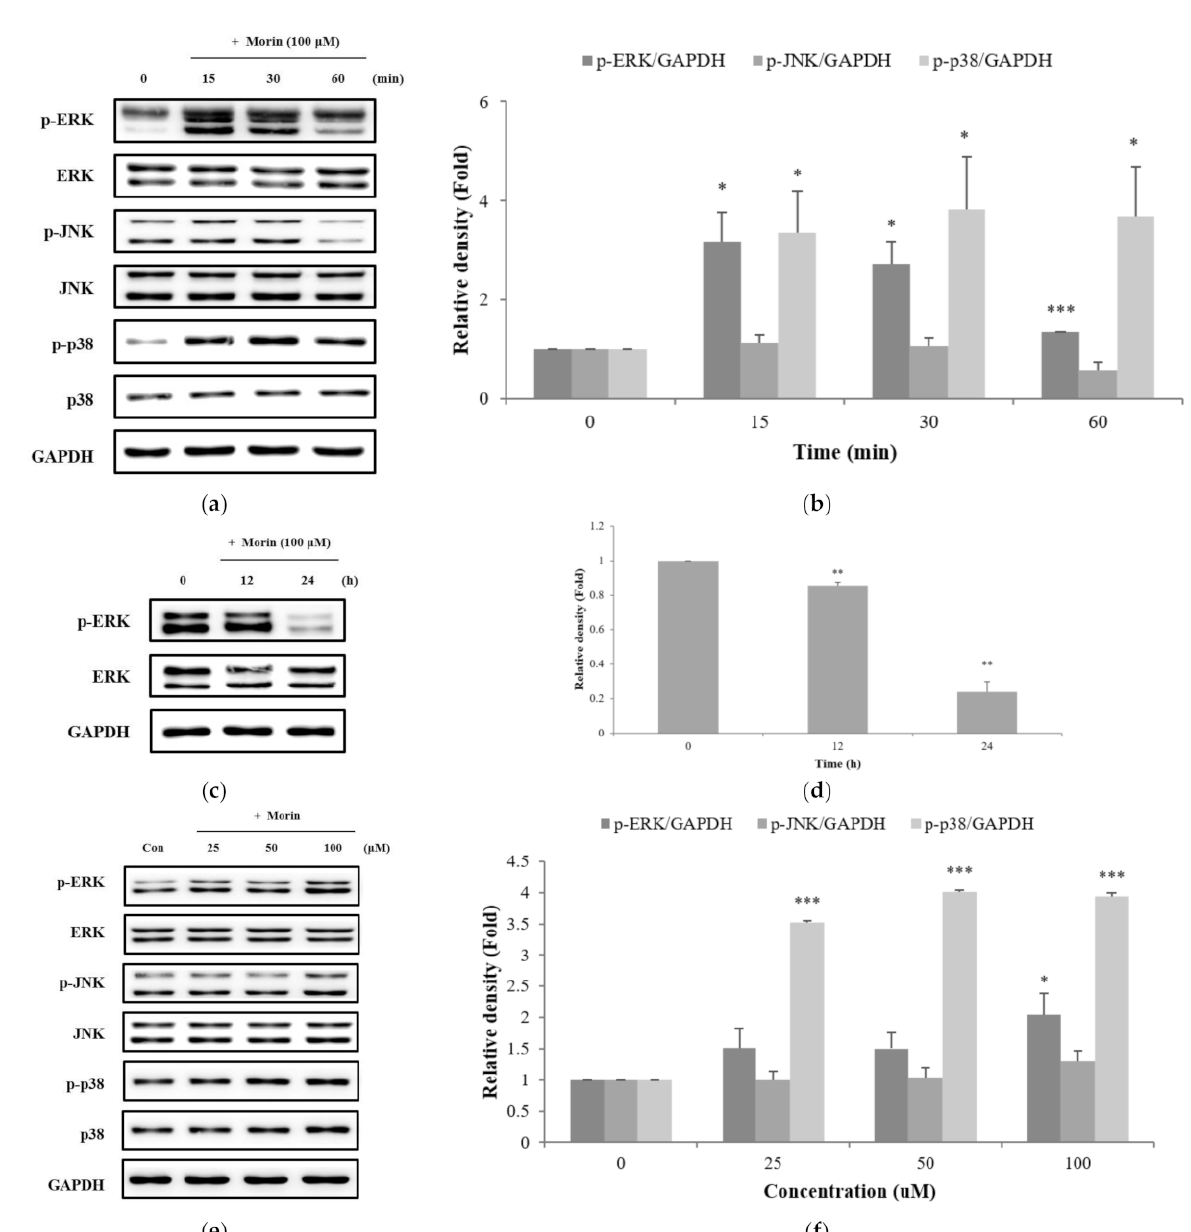
Figure 5. Effects of morin on the protein levels of phosphate ERK, JNK, and p38. B16F10 mouse melanoma cells were treated with morin at ( a , c ) various times, and ( e ) concentrations. Phosphate ERK, JNK, and p38 protein expression were detected by western blotting. ( b , d , f ) Results were normalized against GAPDH expression. The data are presented as the mean ± SD of at least three independent experiments; * p < 0.05, ** p < 0.01, *** p < 0.001 compared with the